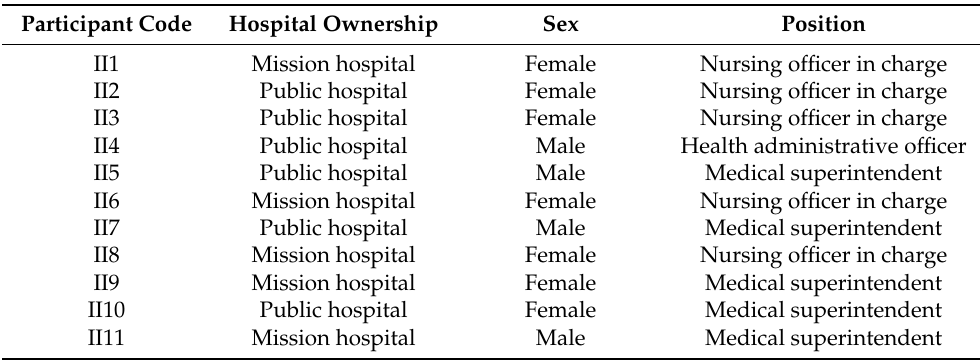
Table 1. Demographic characteristics of